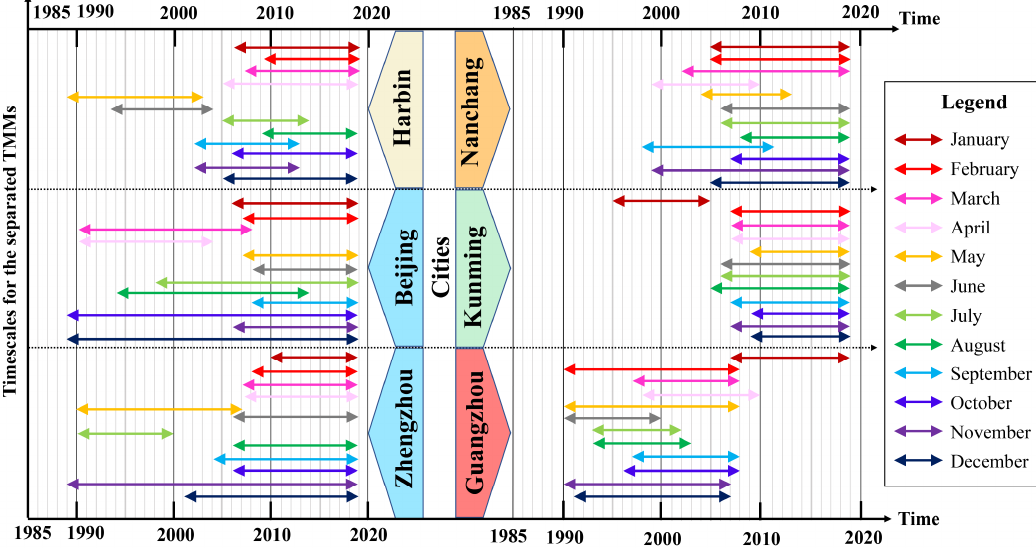
Figure 5. Determining the timescale of six selected